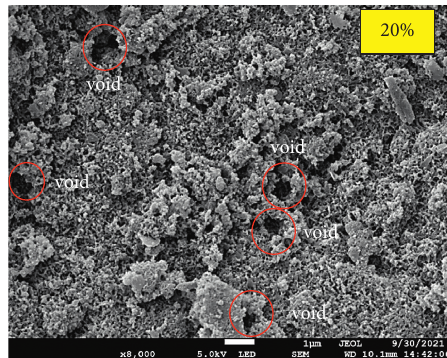
Figure 20: Appearance of lesser void in the POC LWAC specimens containing 20% spent